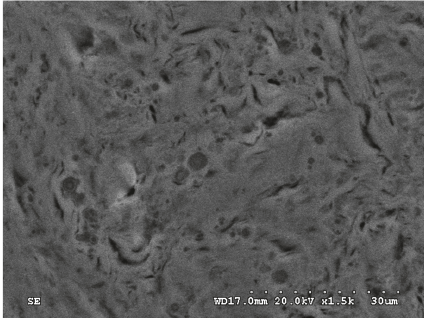
Figure 7: SEM image of A3-3 MG oxidized at 900 ∘ C to 10% weight loss at 1500x